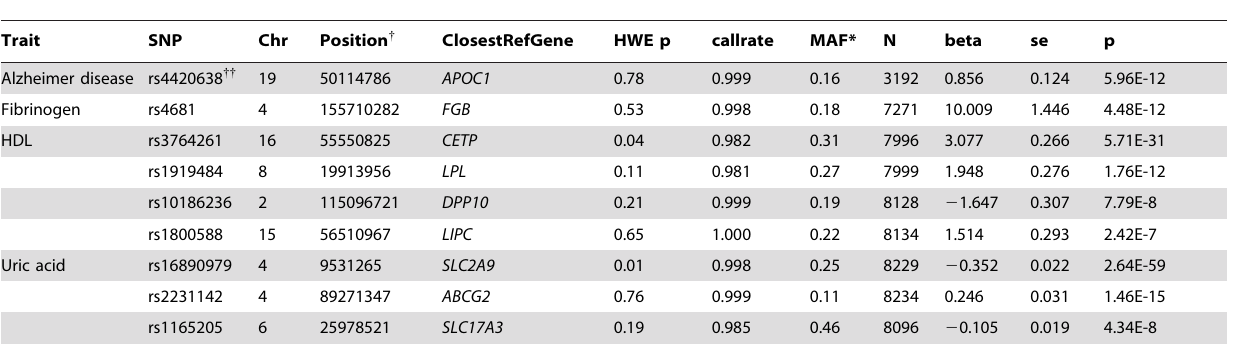
Table 1. Top SNPs (p-value , 1.25E-7) from GWAS of Alzheimer disease, fibrinogen, HDL and uric acid using 550K genotype data.